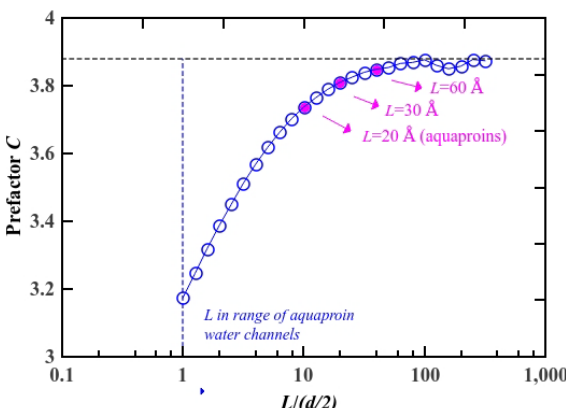
Figure 6. Factor C hydrodynamic resistance from analytical modeling under the partial-slip boundary condition with b = 72 nm. The magnitude of factor C for cylinder nanopores with length of 20 Å (aquaporin water channels), 30 Å and 60 Å are highlighted with the pink dots.